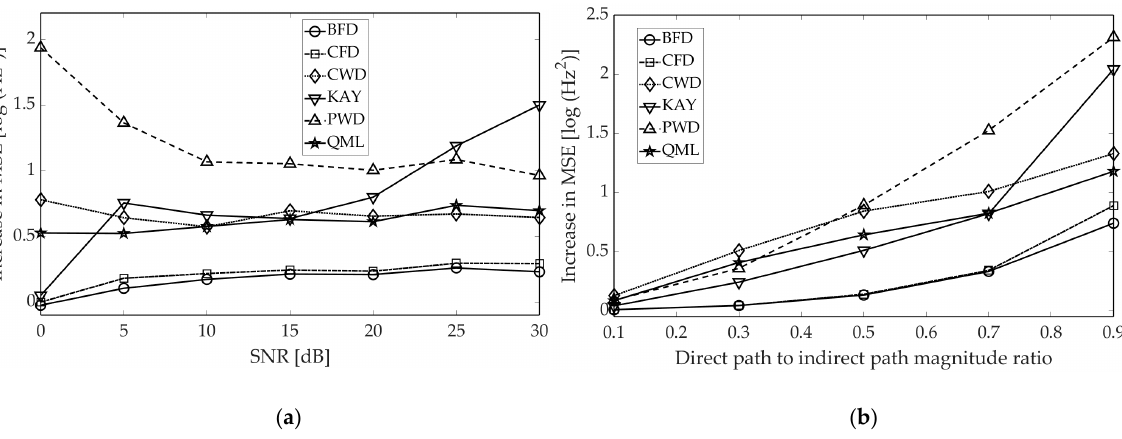
Figure 11. Increase in estimation error in multipath conditions. In order make the results independent of different performance of the estimators at the pulse edges, only the central part of the pulses was taken into account, i.e., 7% of samples on both pulse ends were excluded from the calculation of the MSE. The NLFM A waveform was used. ( a ) Error increase as a function of SNR. Simulation parameters from Table 2 are applied. ( b ) Error increase for a single reflection with fixed ratio of direct pulse to reflected pulse and determined SNR = 15 dB.